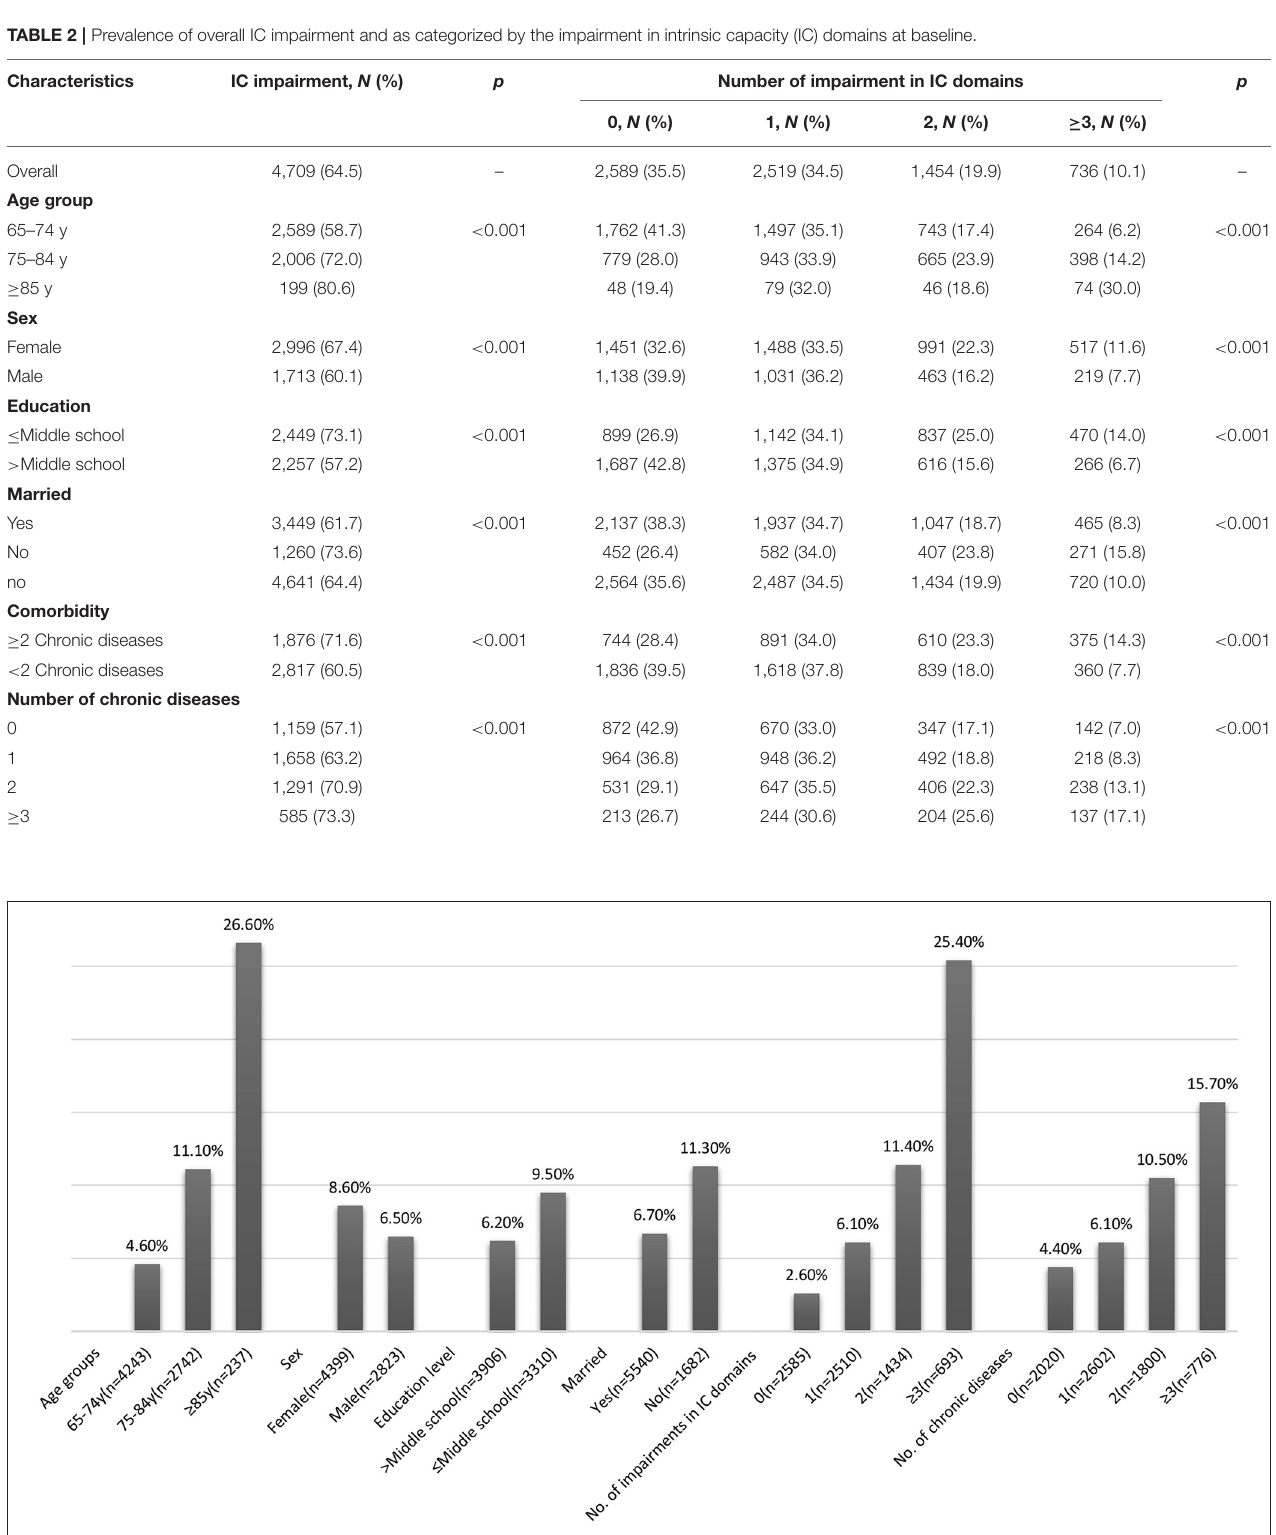
FIGURE 2 | Prevalence of activities of daily living (ADL)